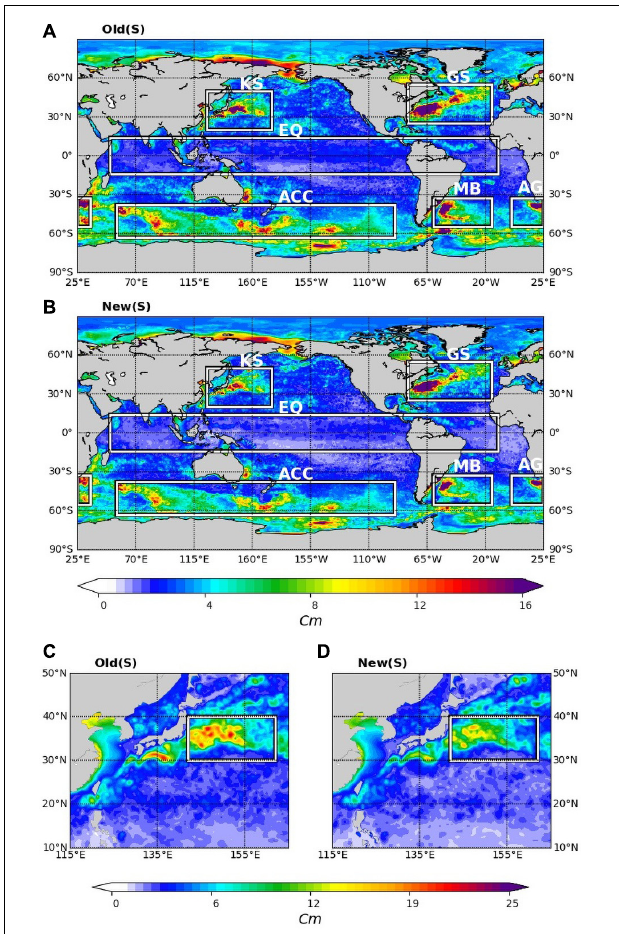
FIGURE 14 | Standard deviation of the SSH Error (NR-Model Forecast, 2015). (A) With old background error covariance and (B) with the new background error covariance. Standard deviation of the SSH. Error on Kuroshio region (NR-Model Forecast, 2015). (C) With old background error covariance and (D) with the new background error covariance.